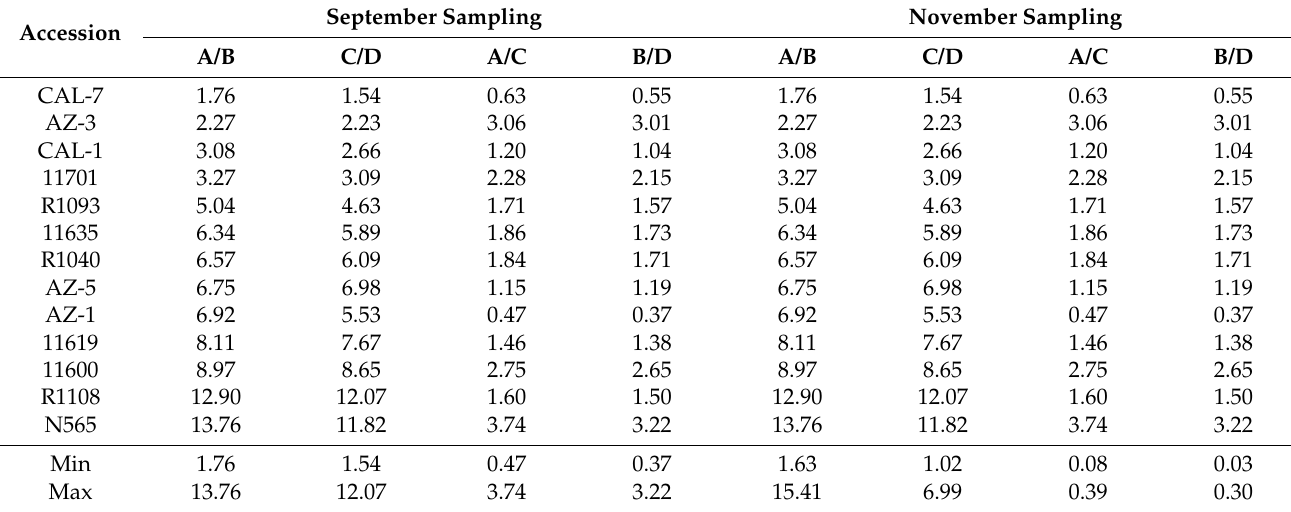
pair of compounds and for the guayulin B/D pair (Table 1). These relationships varied ac- cording to the accession, but with overlapping and common ranges: ratio A/C (min = 0.47;